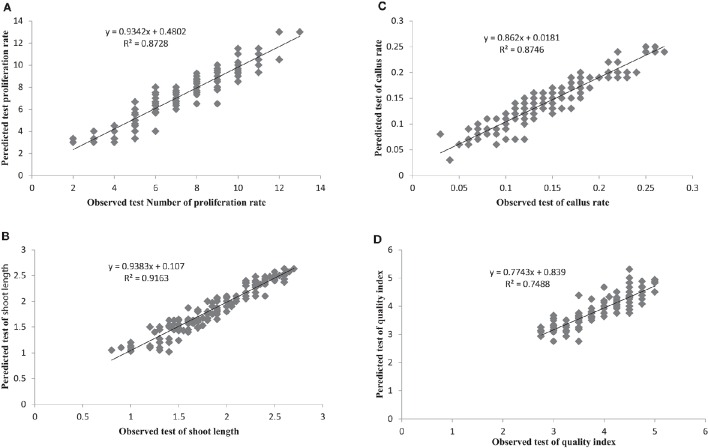
Scatter plot of observed vs. model-predicted values of (A) Proliferation rate, (B) shoot length, (C) Callus rate, and (D) quality index of G × N15 rootstock during in vitro multiplication obtained by artificial neural network model testing set (n = 150). The solid line indicates the fitted simple regression line on scatter points.